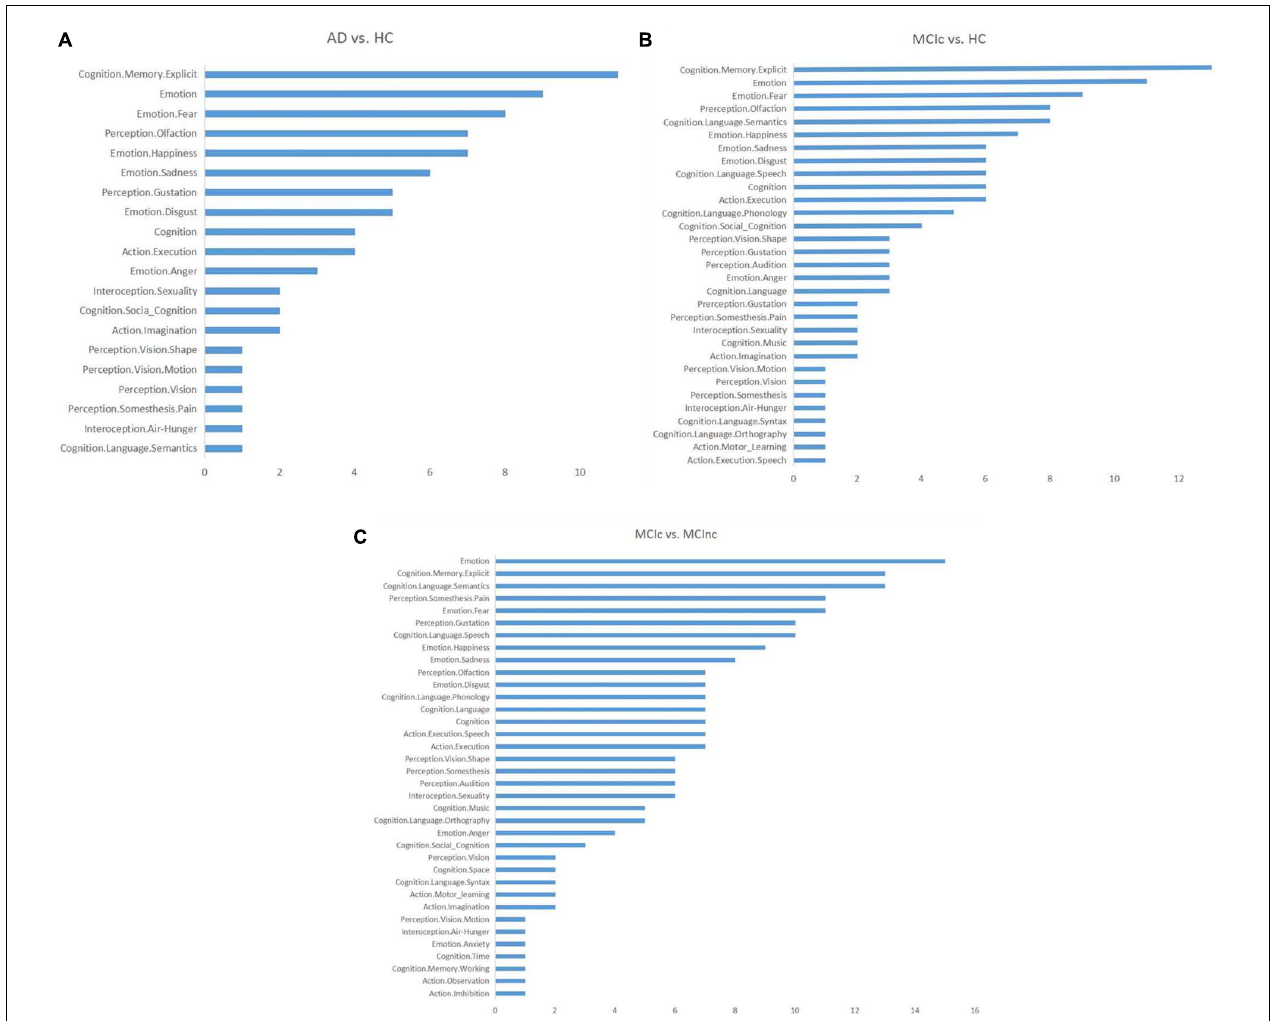
FIGURE 10 | Distributions of the identified brain regions on the relevant behavioral domains in each binary classification task: (A) AD vs. HC; (B) MCIc vs. HC; (C) MCIc vs.